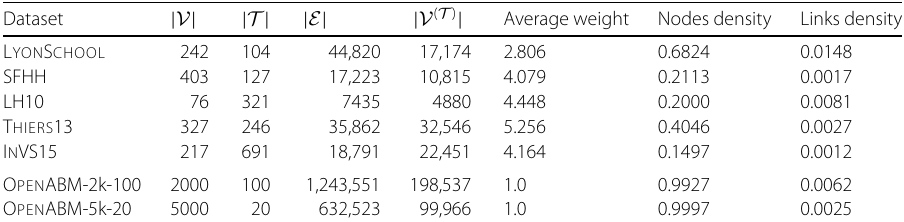
Table 1 Summary statistics about empirical and synthetic time-varying graph data. In order: number of single nodes | V | , number of steps | T | , number of events | E | , number of active nodes | V ( T ) | , average weight of events 1 | E |